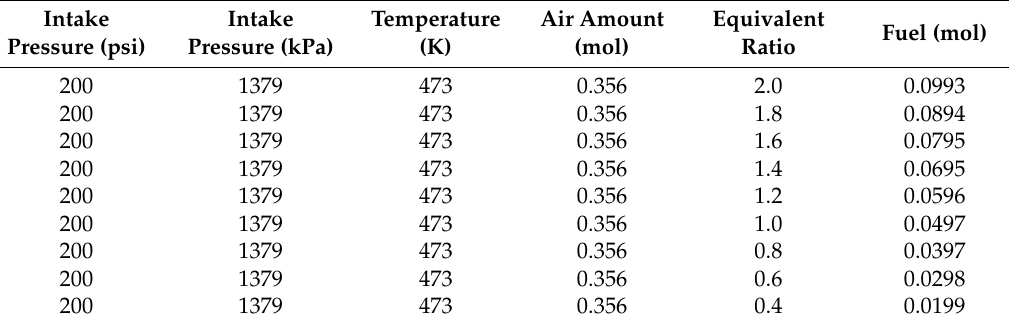
Table 3. Methanol air amount constant test data.